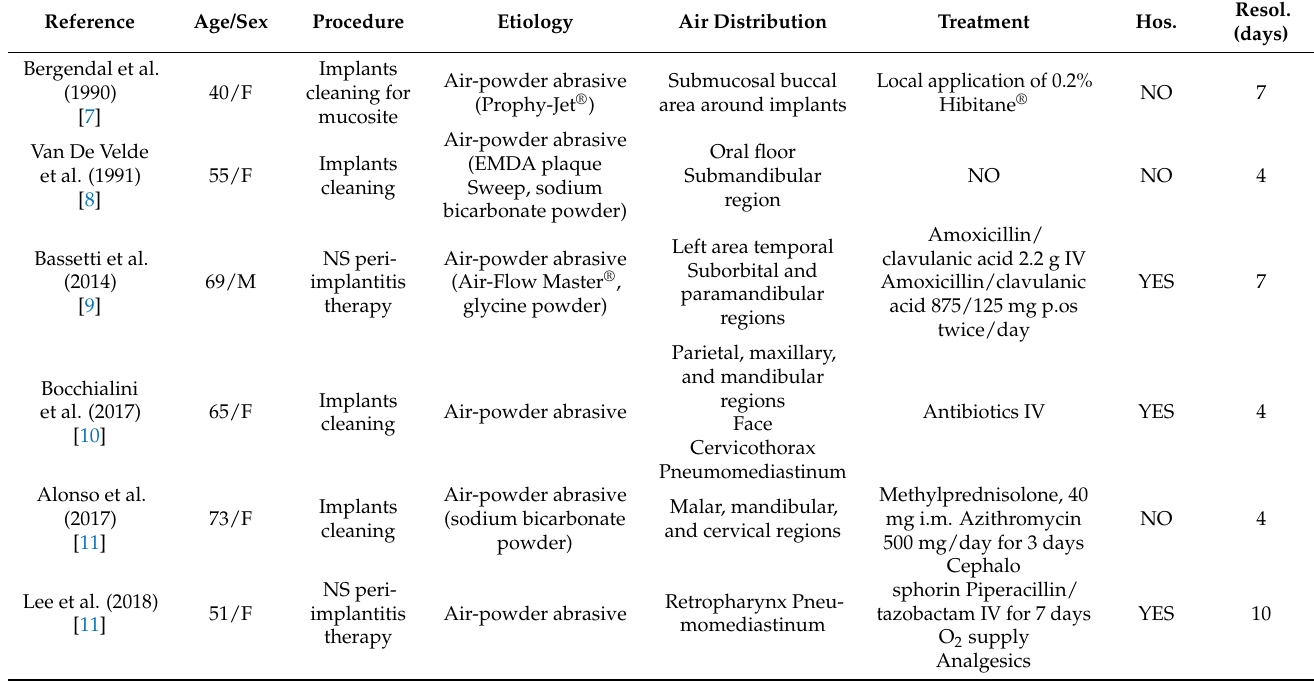
Table 1. Clinical cases of subcutaneous emphysema after peri-implant cleaning or non-surgical peri-implantitis treatment with air-powder abrasive systems (1960 to